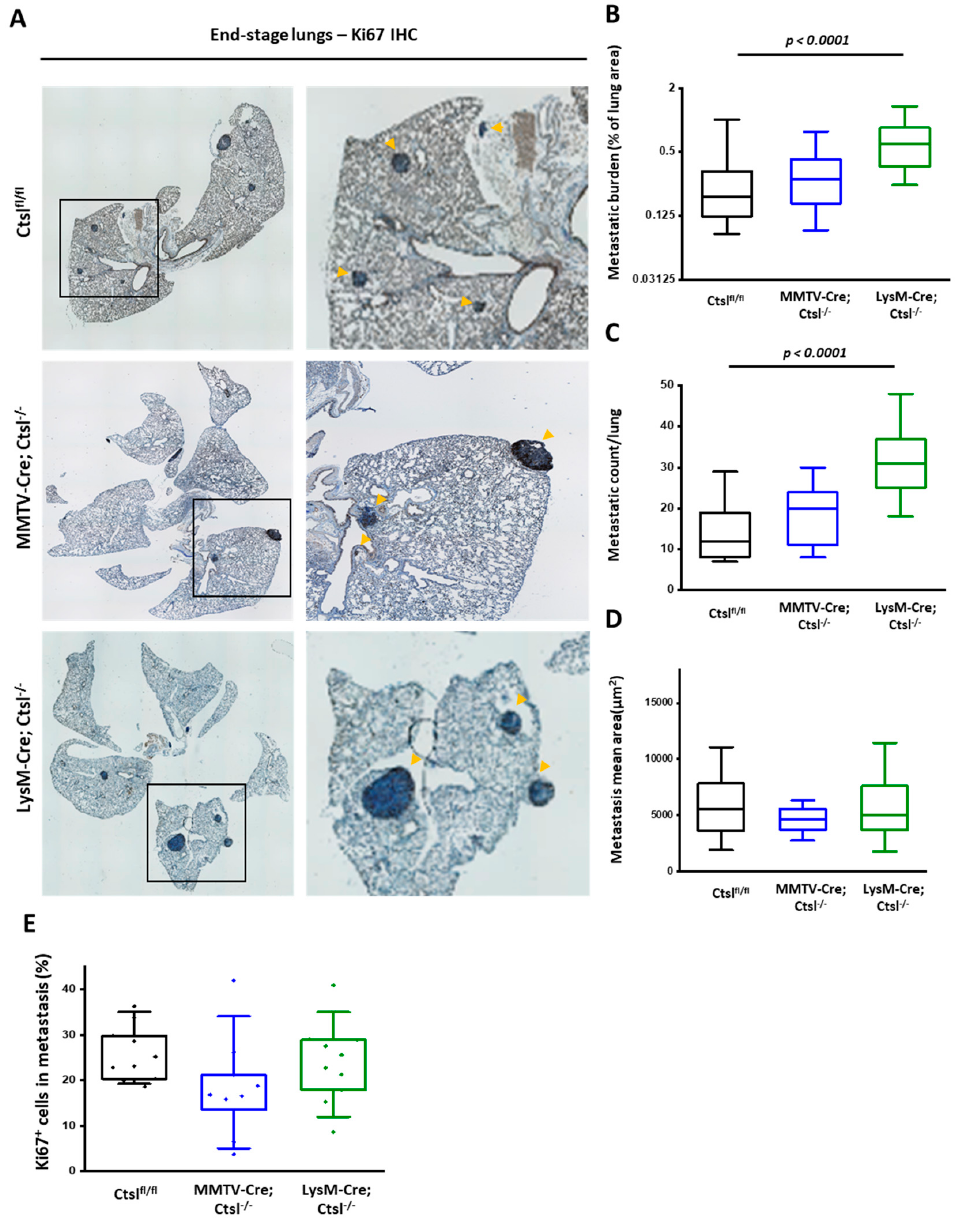
Figure 3. Enhanced lung seeding in end-stage LysM-Cre / Ctsl − / − tumor mice. ( A ) Representative images of Ki67 IHC stainings of end-stage lungs from Ctsl fl / fl , MMTV-Cre / Ctsl − / − , LysM-Cre / Ctsl − / − conditional knockout mice. Arrowheads highlight the lung metastases, which appear as darker spots within the lung parenchyma. Single images were recorded at 4 × magnification and at least 6x6 frames were stitched together to depict whole lungs in an automated manner by the Keyence software. ( B ) Metastatic burden and ( C ) count across all genotypes show a significant increase in metastatic burden and count in the lungs of LysM-Cre / Ctsl − / − end-stage tumor mice, bearing the deletion in myeloid cells ( p < 0.0001, Mann–Whitney). Lungs from MMTV-Cre / Ctsl − / − mice display no di ff erences in their metastatic burden when compared to littermate controls. ( D ) Mean metastasis area remains constant, and thus not significantly changed across genotypes ( Ctsl fl / fl n = 46; MMTV-Cre / Ctsl − / − n = 17; LysM-Cre / Ctsl − / − n = 25). ( E ) Ki67-posive proliferating cells in lung metastases ( n = 7 per group). In the box plots, the boundary of the box closest to zero indicates the 25th percentile, the line within the box marks the median, and the boundary of the box farthest from zero indicates the 75th percentile. Whiskers indicate the 10th and 90th percentiles.